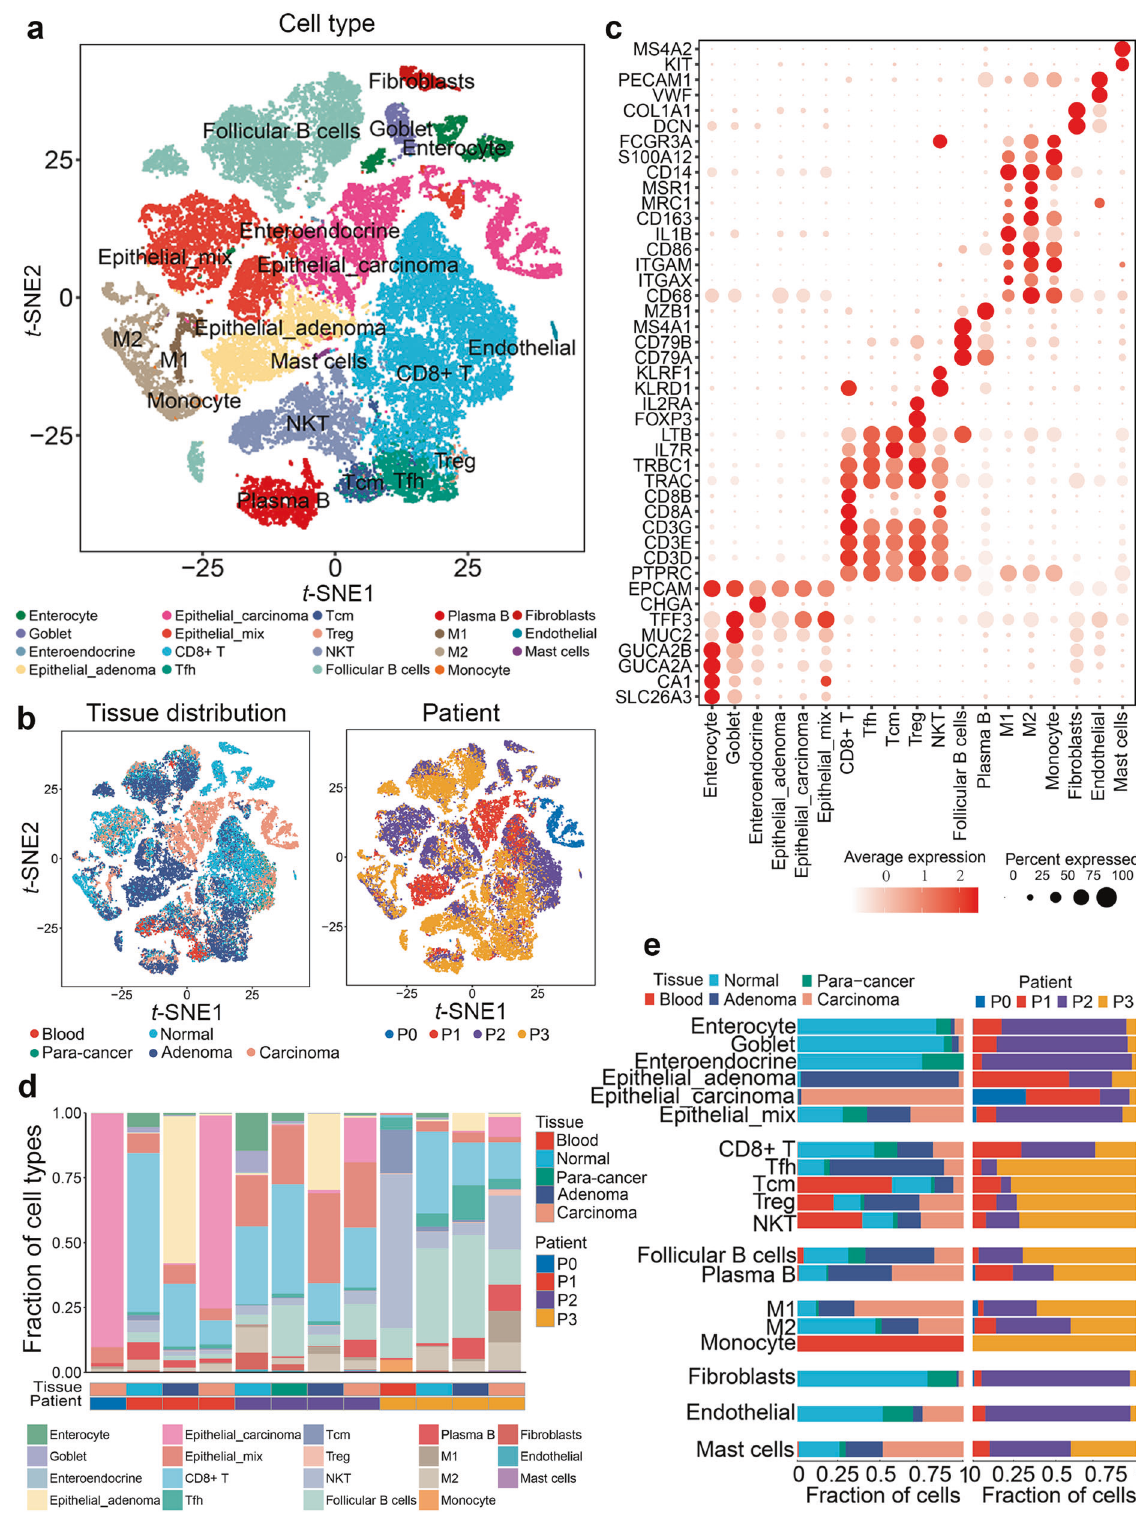
Fig. 2 Cell type constitution of colorectal normal, para-cancer, adenoma, and carcinoma tissues. a t -SNE plots of cells from four patients (12 samples). Colors represent cell types. Cells were clustered into 19 sub-clusters based on biological annotation. Each dot represents a single cell. b t -SNE plots of tissue origin (left) and patient origin (right). Each dot represents a cell, and colors correspond to cell origins. c Log- normalized expression levels of canonical marker genes for the above 19 cell types. Circle size represents the percentage of cells that express the gene, and colors represent the average expression value within a cluster. d Bar plot showing the fraction of each cell type in 12 samples, with rows representing cell types and columns representing samples. e Bar plot presenting the fraction of tissue origin (left) and the fraction of patient origin (right) for the 19 cell types. Colors represent cell origins